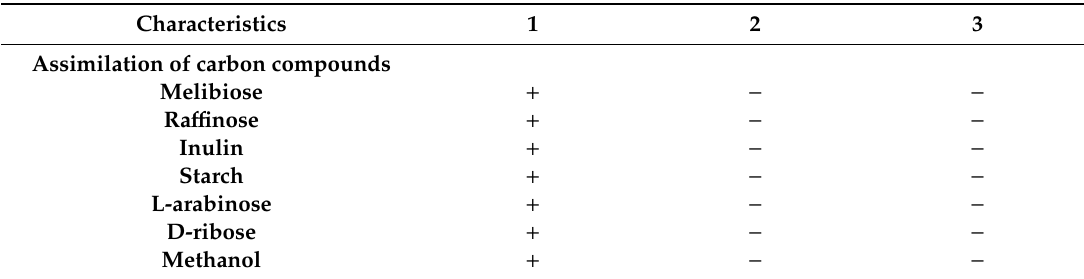
Table3. Di ff erentialcharacteristicbetween Limtongellasiamensis DMKU-JMGT1-45 T ,